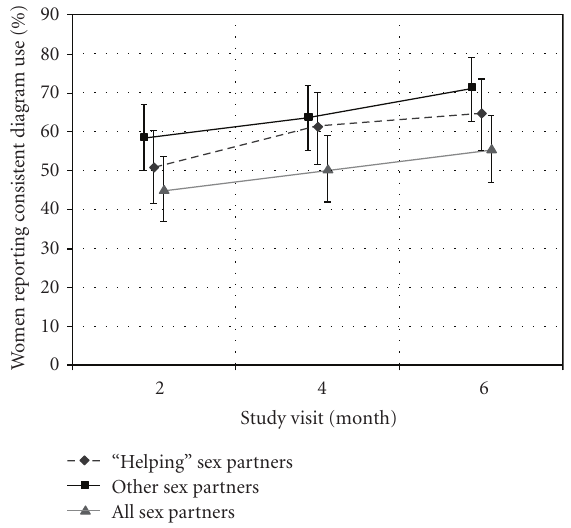
Figure 1: Prevalence of consistent diaphragm use, by partner type and study visit, Diaphragm Acceptability Study, Nairobi, Kenya, 2004-2005. Consistent use defined as diaphragm use during 100% of coital acts in the previous 2 weeks. Analysis restricted to women with at least one coital act in the previous 2 weeks with the relevant partner type. Bars represent 95% confidence